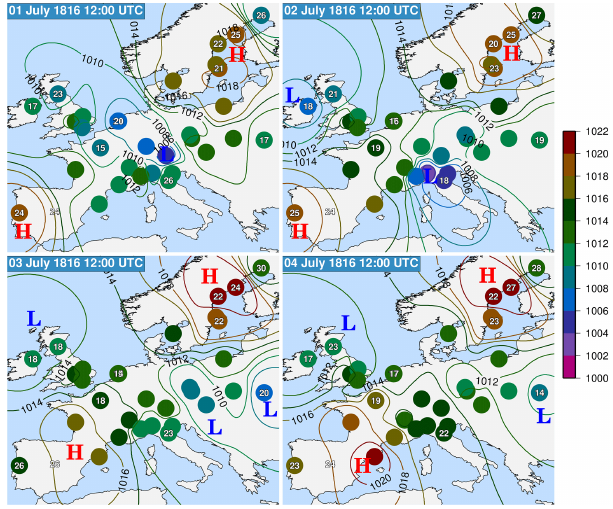
Figure 10. Similar to Fig. 9, but showing maps for the first 4 days of July 1816 at 12:00UTC. Note that the colour scale has changed and isobars are drawn at intervals of